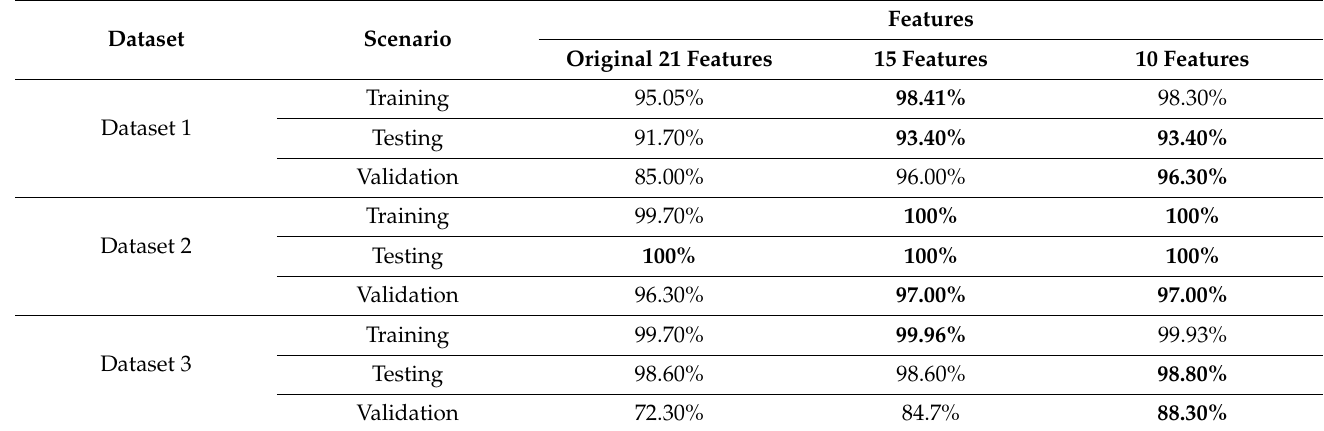
Table 3. Training, testing, and validation accuracy for all datasets and